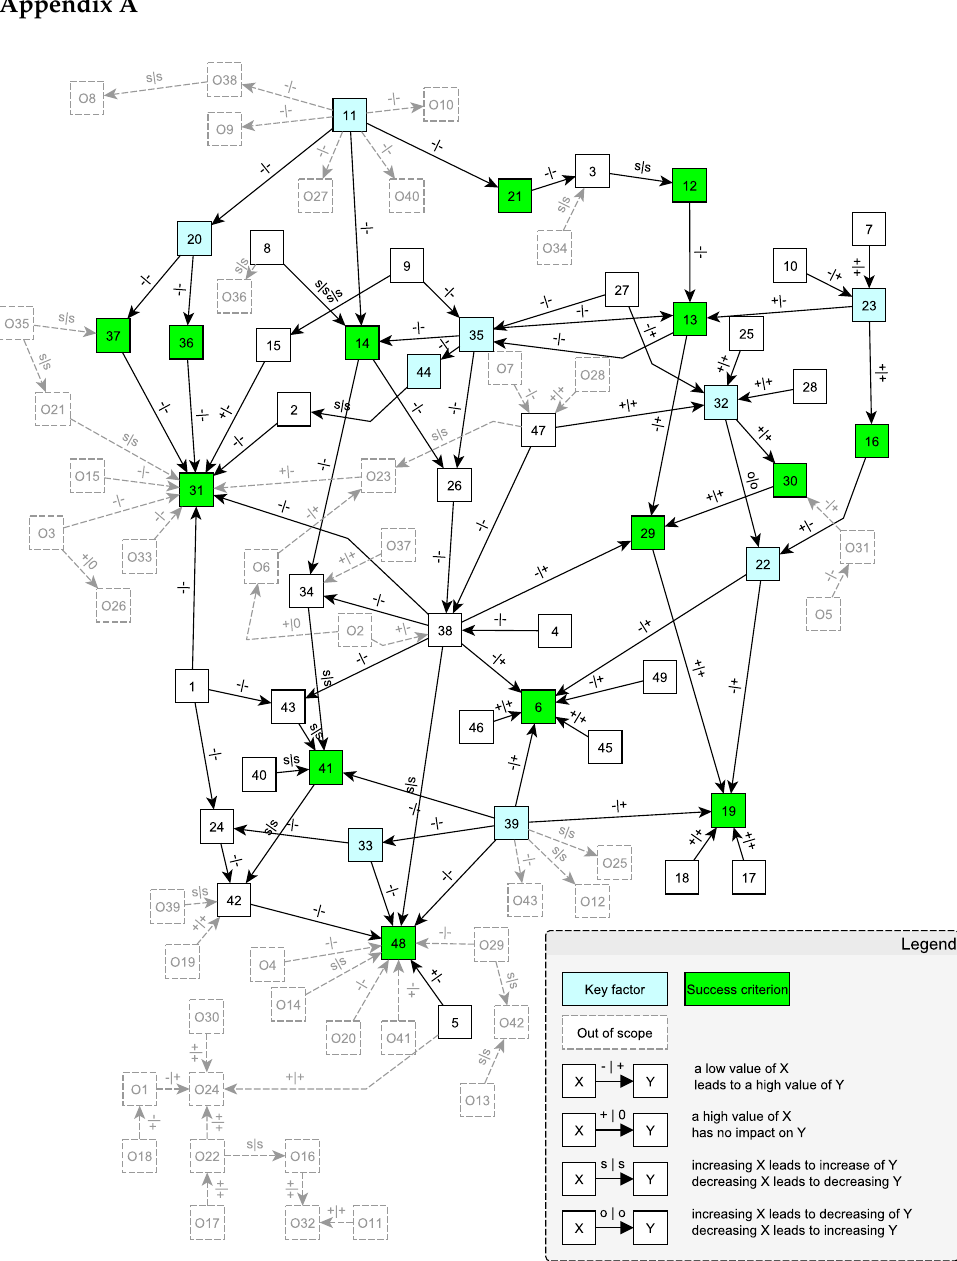
Figure A1. Reference model based on Design Research Methodology described in [23]. How to read the model: Take for example the connection 11 to O9. 11 stands for the degree of reusability of documented domain knowledge (looked up in Table A2). O9 stands for comprehensibility of the trained AI model (looked up in Table A1). 11 and O9 are linked with the label -|-. This means: Currently there is a low degree of reusability of documented domain knowledge and this leads to low comprehensibility of the trained AI model. As O9 is out of scope, the SemDaServ solution will not take this connection into